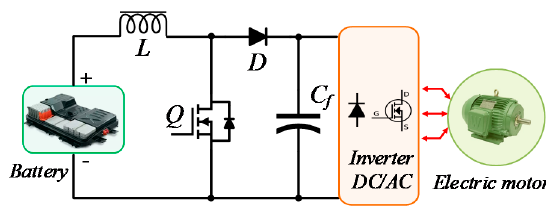
F igure 6. DC-DC Boost Converter. Figure 6. DC-DC Boost 3.2. Interleaved 4-Phase Boost DC-DC Converter (IBC)